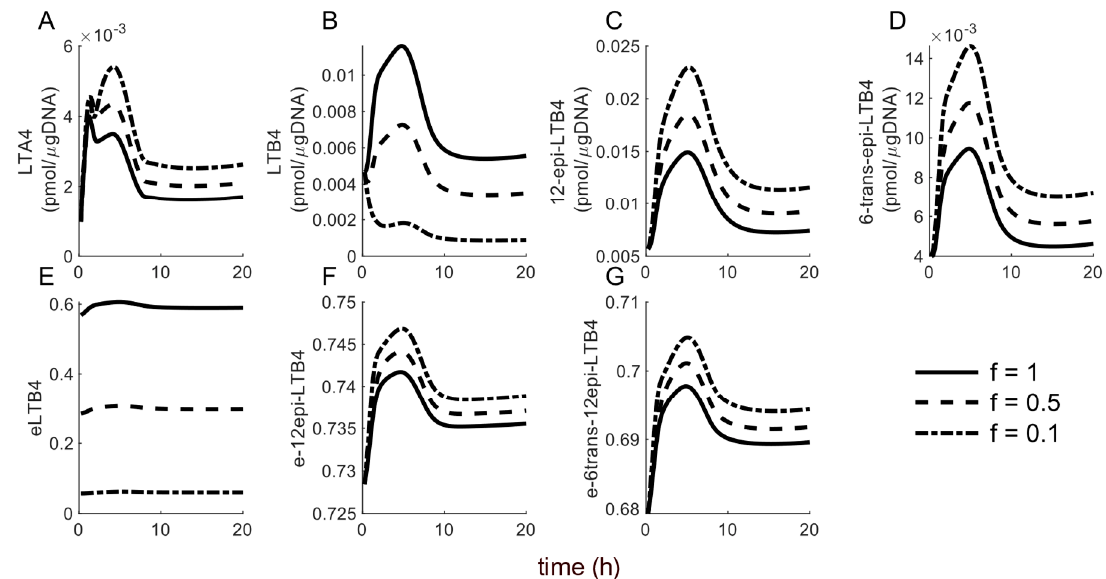
Figure 6. Gene knockdown perturbation profiles for LTs branch for metabolites and intermediates ( A – D ) and scaled enzymes ( E – G ). A simulated enzyme perturbation to the LTB 4 branch of the network alters the Ltbd4h (eLTB 4 ) enzyme levels. A lower f value corresponds to a decrease in the constitutive and inducible enzyme synthesis rates of Ltbd4h. We observed the lower concentrations of eLTB 4 as f decreases, as expected ( E ). The elevated LTA 4 levels ( A ) in response to lower fractional enzyme level f are due to decreased flux from LTA 4 to LTB 4 and the subsequent accumulation of LTA 4 prior to generating enough enzymes for the remaining metabolic products in the branch. LTB4 levels reduced ( B ), and the increase in LTA 4 led to increased fluxes and increased concentrations of 12epi-LTB 4 and 6t-epi-LTB 4 ( C , D ) to balance the no-change in influx from AA to LTA 4 . We observe a slight increase in enzyme levels for the other metabolites (e-12epi-LTB 4 ( F ), e-6t-epi-LTB 4 ( G )) because of increased substrate LTA 4 levels.